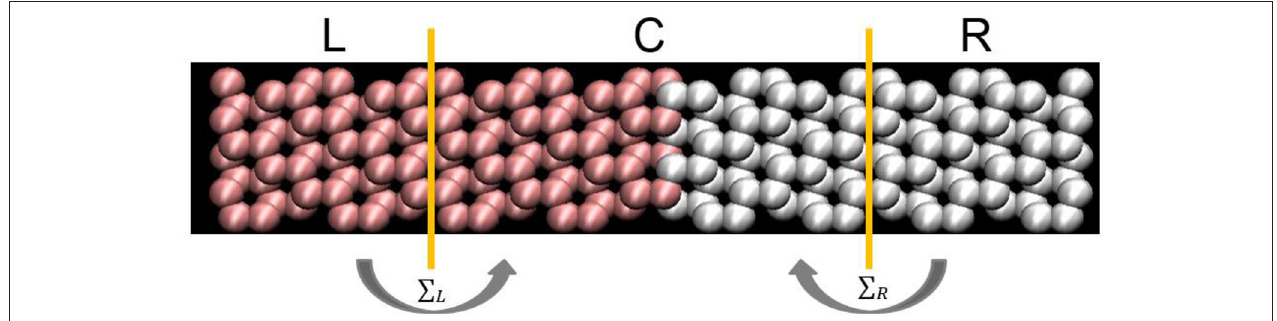
FIGURE 1 | Silicon with perfect 6 3 grain boundary. The system is partitioned into three regions: left lead (L), center region (C), and right lead (R). Left and right leads are semi-infinite crystal lattices. All the three regions impose periodic boundary conditions in the transverse direction to represent the infinite lateral dimension. The grain boundary has 2 layers and each layer has 8 atoms. The unit cell of center region contains 96 atoms and the unit cell of each lead is composed of 48